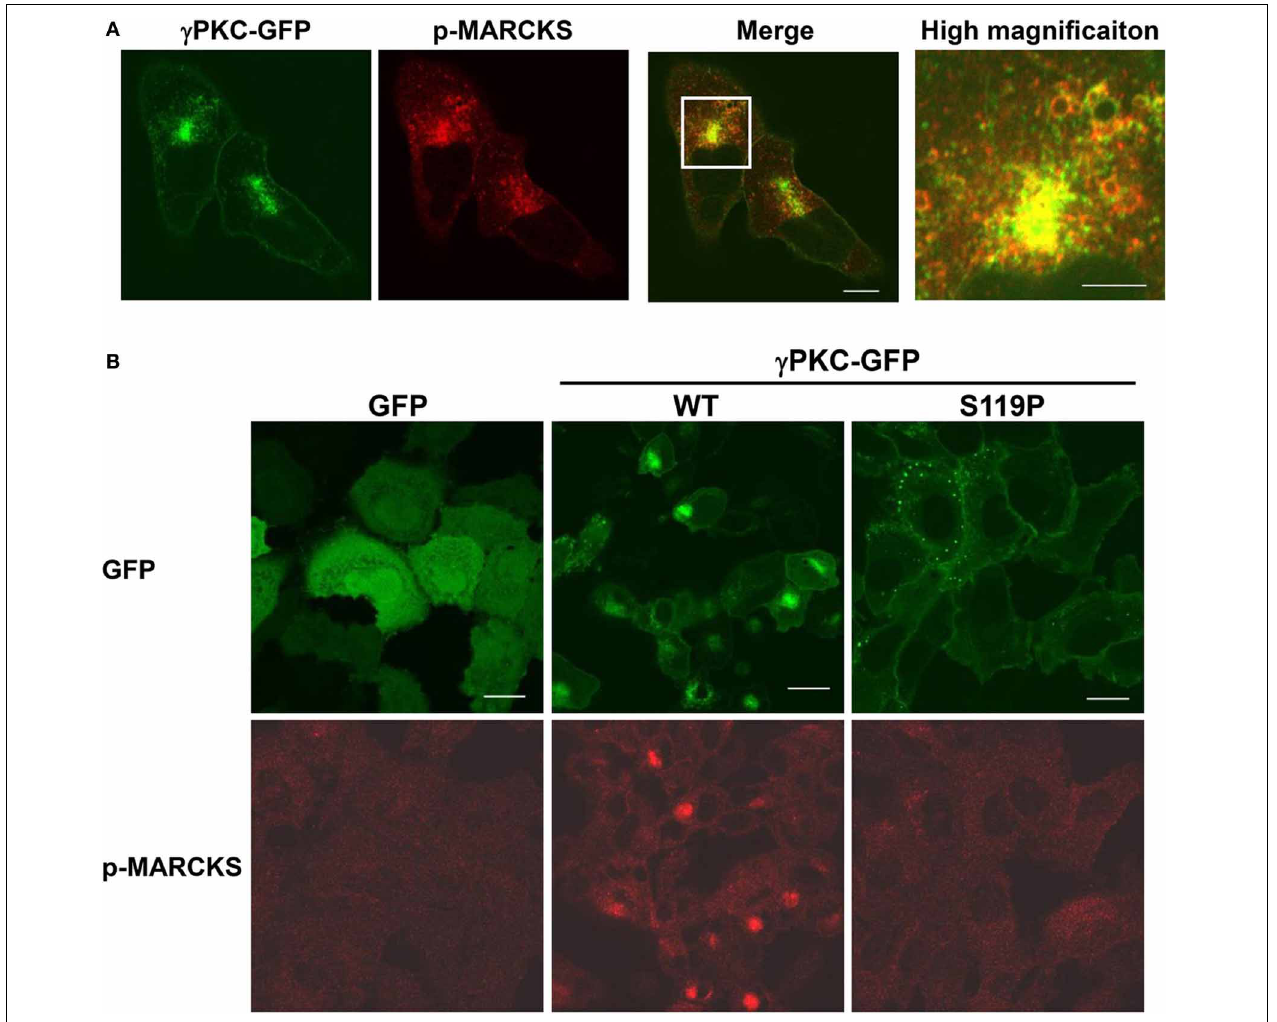
γ PKC-GFP, especially around the vesicles. The scale bars of the merged and high magnification images are 5 and 2 μ m, respectively. (B) Localization of p-MARCKS in cells expressing GFP alone, WT and S119P γ PKC-GFP 30min after TPA treatment. Representative images (p-MARCKS and GFP) are shown. As described above, p-MARCKS was colocalized with WT γ PKC-GFP in the perinuclear region. In contrast, obvious p-MARCKS immunostaining was not observed in cells expressing GFP alone or mutant γ PKC-GFP. Scale bar = 10 μ m.